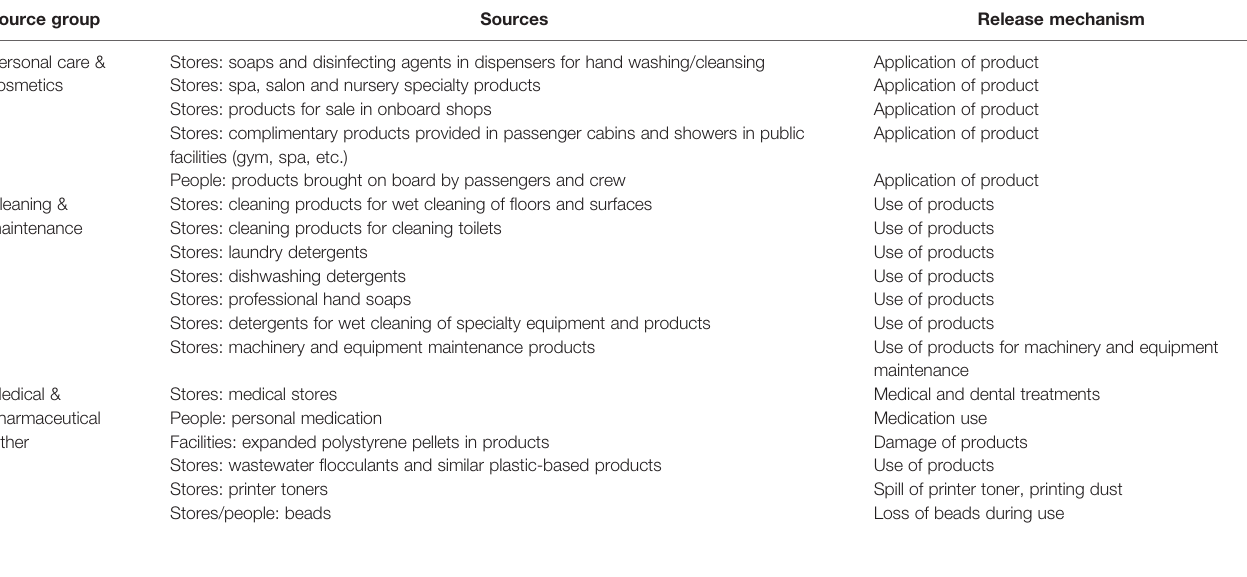
TABLE 5 | Primary microplastic sources and release mechanisms with relevance to cruise ship